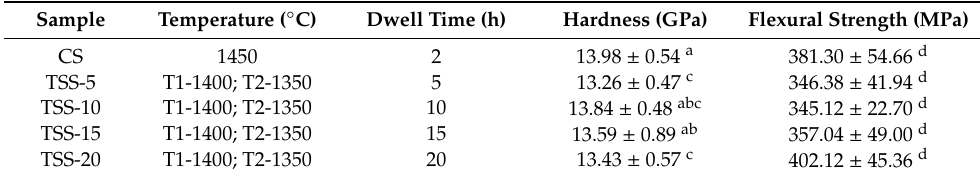
Table 2. Mechanical properties of conventionally sintered and two-step sintered samples prepared from as-received powder.